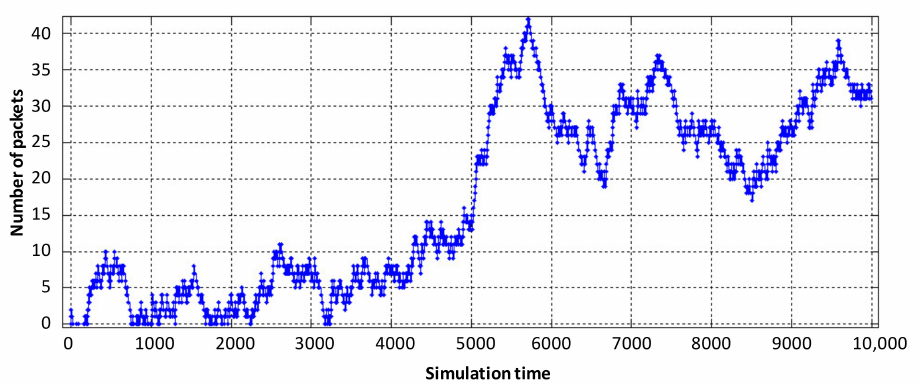
Figure 10. Loading the physical router buffer with Triple Play flows.